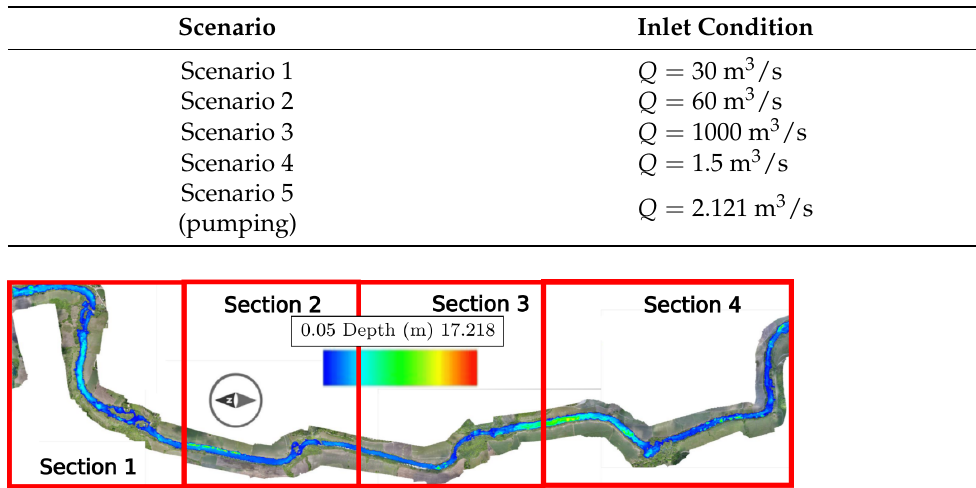
Table 5. Initial water flow for each scenario.